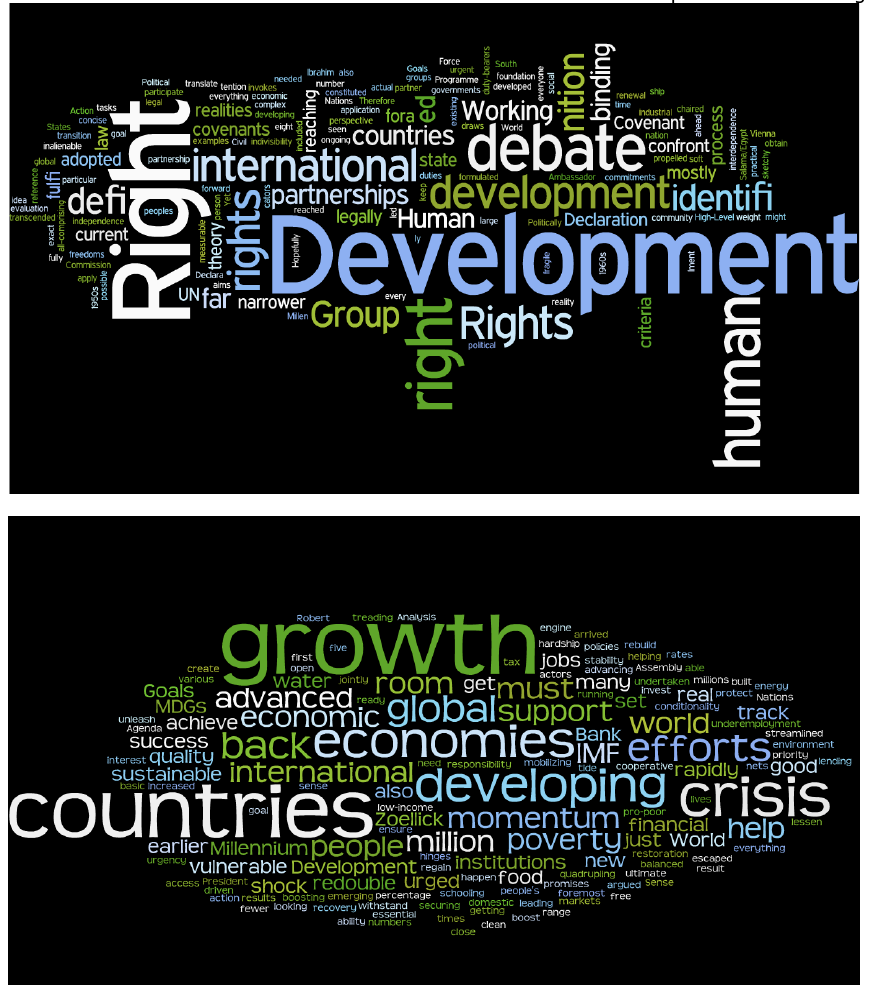
FIGURE 2 : WORDLES FROM TEXTS ON THE UN AND WORLD BANK